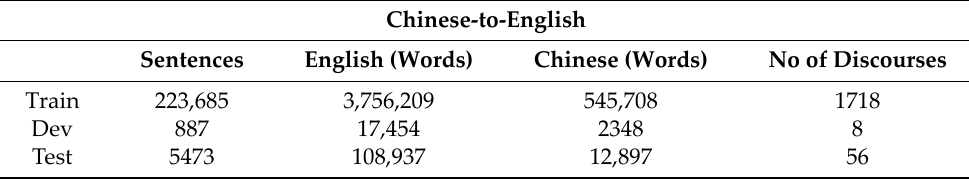
Table 3. Corpus statistics for